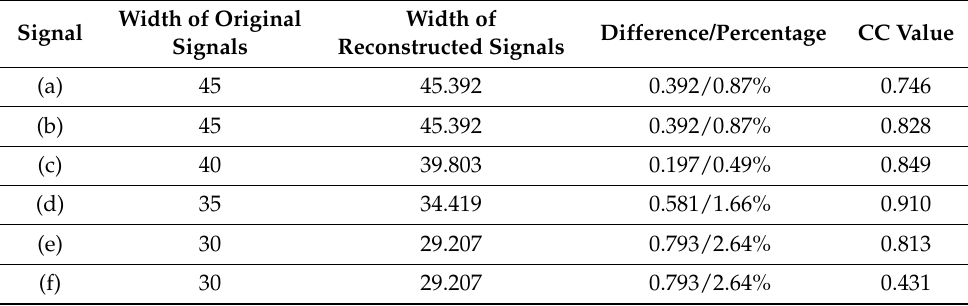
Table 3. Maximum widths a and CC values of six separated 2-D circular fringe patterns from Figure 3a.